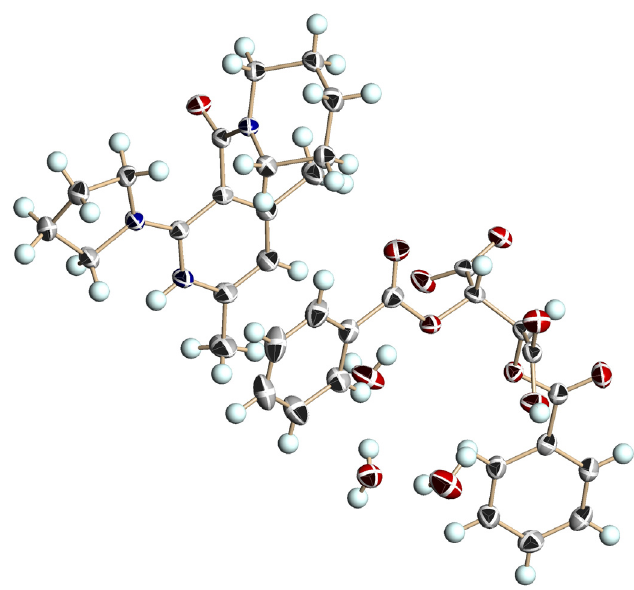
O from the c axis. A 2 helix 2 1